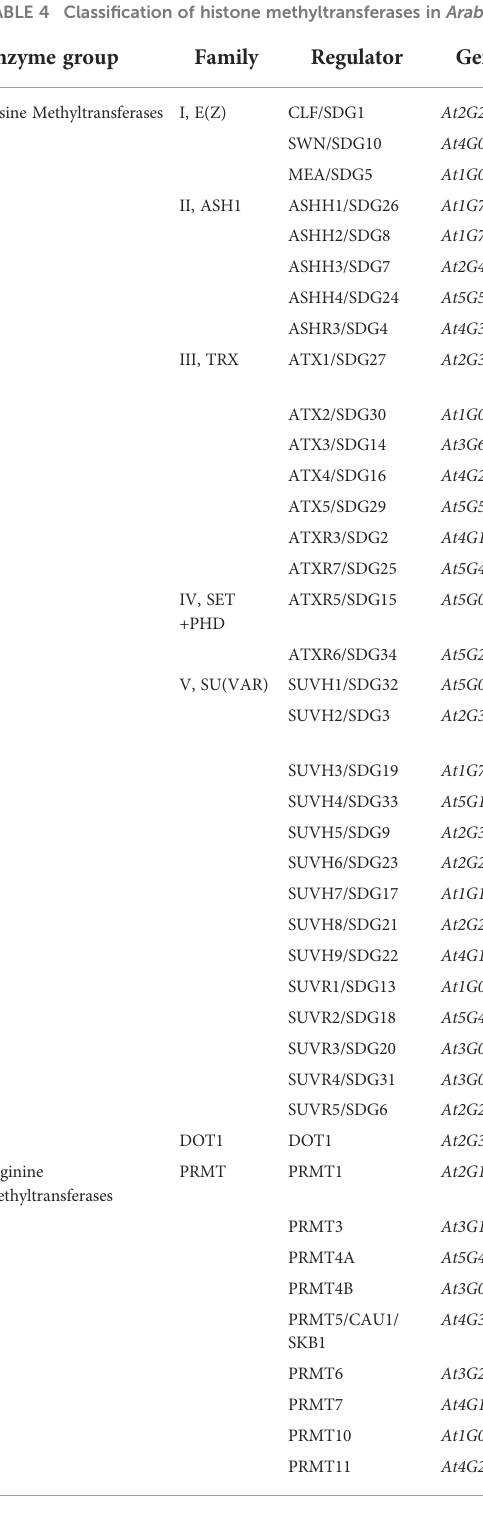
TABLE 4 Classi fi cation of histone methyltransferases in Arabidopsis